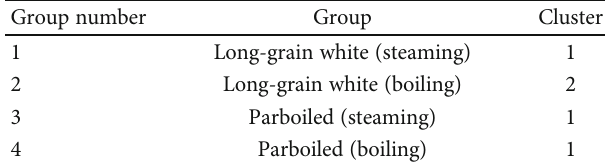
Figure 6: Minimum spanning tree. Table 5: Clusters.